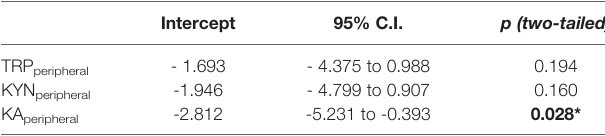
TABLE 3 | Results of Egger ’ s tests for publication